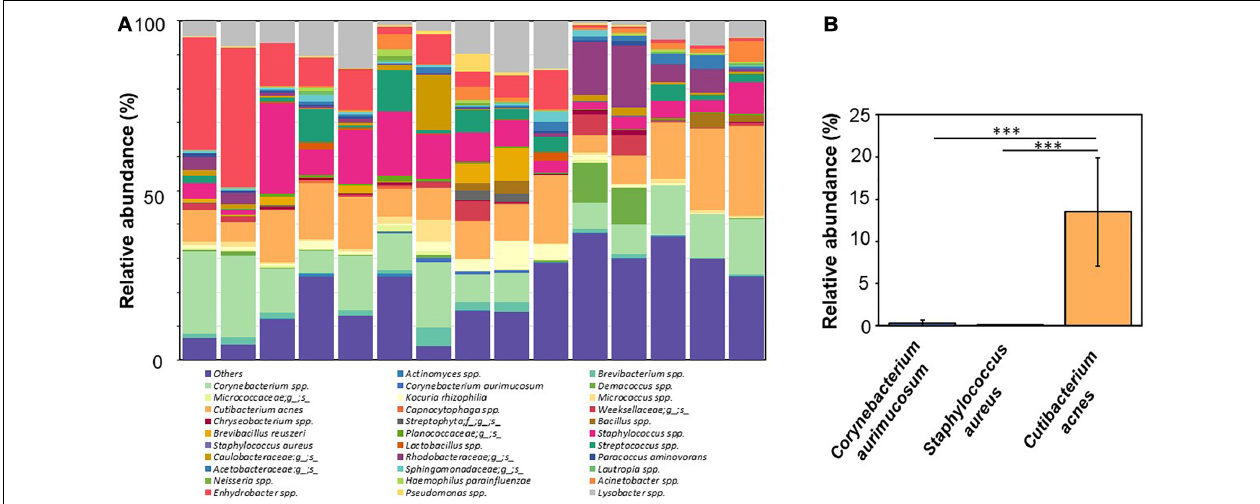
FIGURE 1 | NGS-analyzed microbiome composition at species level with relatively high abundance of C. acnes and low abundance of S. aureus and C. aurimucosum in the human skin. (A) NGS analyzed by a Roche 454 FLX titanium instrument using 16S rRNA gene was conducted after extraction of DNA from swab samples of facial skin of 15 human subjects. Four bacteria species [ Corynebacterium spp. (pale green), C. acnes (orange), Staphylococcus spp. (pink), and Enhydrobacter spp. (pink–red)] with average relative abundances ≥ 10% in more than 5 of 15 human subjects were detected. Bacteria with relative abundances ≥ 1% in skin of at least one individual or bacteria identified at the species level were presented. Bacteria with an abundance < 1% were pooled and indicated as “Others.” (B) The relative abundances of C. acnes (orange), S. aureus (purple), and C. aurimucosum (blue) are displayed. The mean ± SD obtained from 15 subjects was calculated. p < 0.001 ( ∗∗∗ ), two-tailed t -test, is shown.